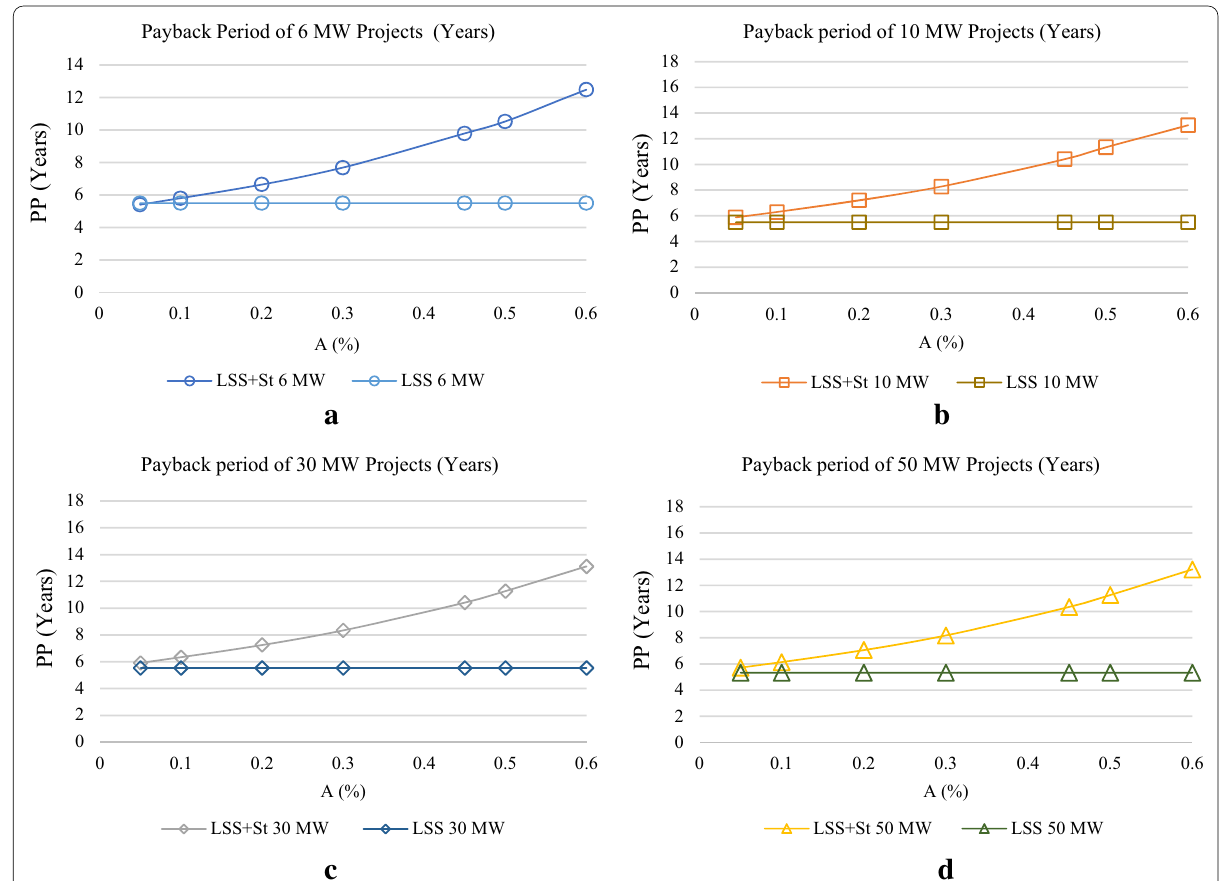
Fig. 10 Payback period of the different investment types for each LSS capacity. a 6-MW projects, b 10-MW projects, c 30-MW projects, d 50-MW